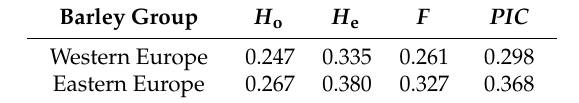
Table 3. Genetic variability indices of barley accessions in the two European regions. Barley Group H o H e F PIC Western Europe 0.247 0.335 0.261